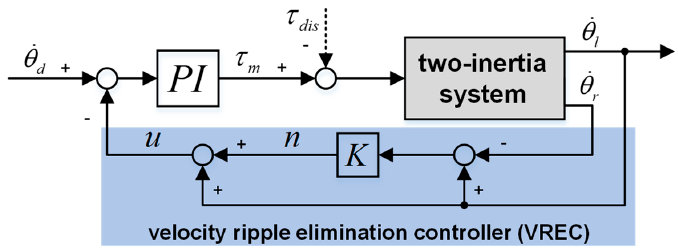
Figure 7. Block diagram of the link-side controller.